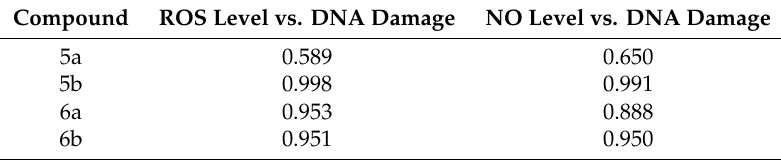
Table 4. Pearson correlation coefficients between DNA damage and ROS or NO levels. Compound ROS Level vs. DNA Damage